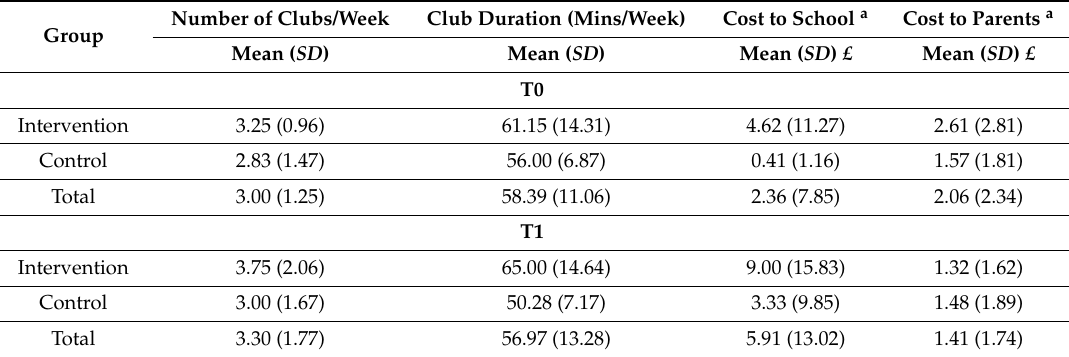
Table 5. Summary of T0 and T1 after-school physical activity